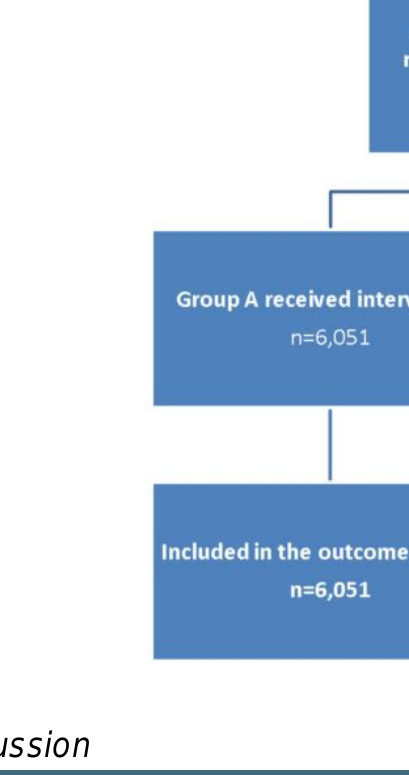
Figure 1. CONSORT